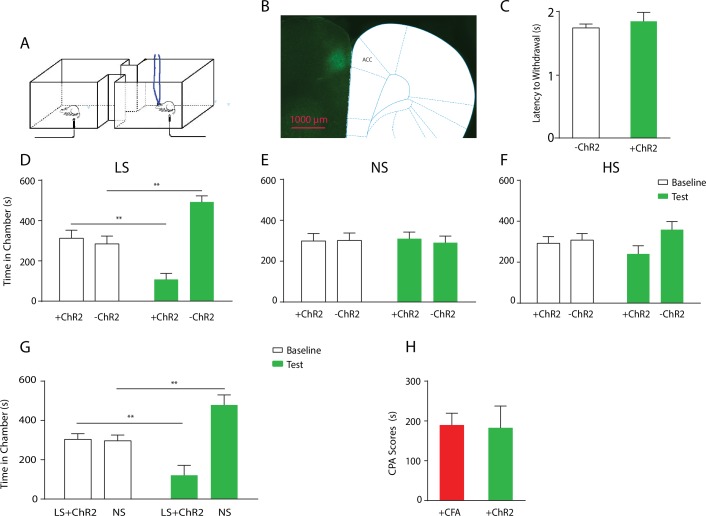
Optogenetic activation of the ACC has similar effects as chronic pain in enhancing the aversive response to acute pain.(A) Schematic for a CPA test during optogenetic activation of the ACC. Light activation of the ACC was temporally coupled with peripheral stimulation to the paw. (B) Histologic expression of ChR2 in the ACC. (C) Light activation of the ACC did not alter paw withdrawal latency to noxious stimuli. n = 5; p=0.4654, paired Student’s t test. (D) ACC activation increased the aversive response to LS. One of the chambers was paired with optogenetic stimulation of the ACC and LS; the other chamber was paired with LS without ACC activation. Rats spent less time during the test phase than at baseline in the chamber paired with LS coupled with ACC activation and more time in the chamber paired with LS alone. n = 8; p=0.0026. (E) ACC activation did not elicit an aversive response to NS. One of the chambers was paired with ACC activation and NS; the other chamber was paired with NS alone. n = 9; p=0.7514. (F) ACC activation did not increase the aversive response to HS in a statistically significant manner. One of the chambers was paired with ACC activation and HS; the other chamber was paired with HS alone. n = 10; p=0.1584. (G) Coupling with ACC activation increased the aversive response of LS compared with NS. One of the chambers was paired with optogenetic stimulation of the ACC and LS; the other chamber was paired with NS alone. Rats spent significantly less time during the test phase than at baseline in the chamber paired with ACC activation and LS. n = 11; p=0.0075. (H) ACC activation caused a similar increase in the aversive response to LS as chronic pain. For comparison, rats were conditioned with LS and NS in separate chambers in both experiments. In one experiment (3G), LS was coupled with ACC activation, and the CPA score was calculated by subtracting the amount of time spent during the test phase from baseline in the chamber paired with simultaneous ACC activation and LS. In the second experiment, conditioning was performed in CFA-treated rats without ACC activation. A CPA score was calculated by subtracting the amount of time spent during the test phase from baseline in the chamber paired with LS in CFA-treated rats. The CPA scores from these two different experiments were similar. n = 9–11; p=0.9161, unpaired Student’s t test.